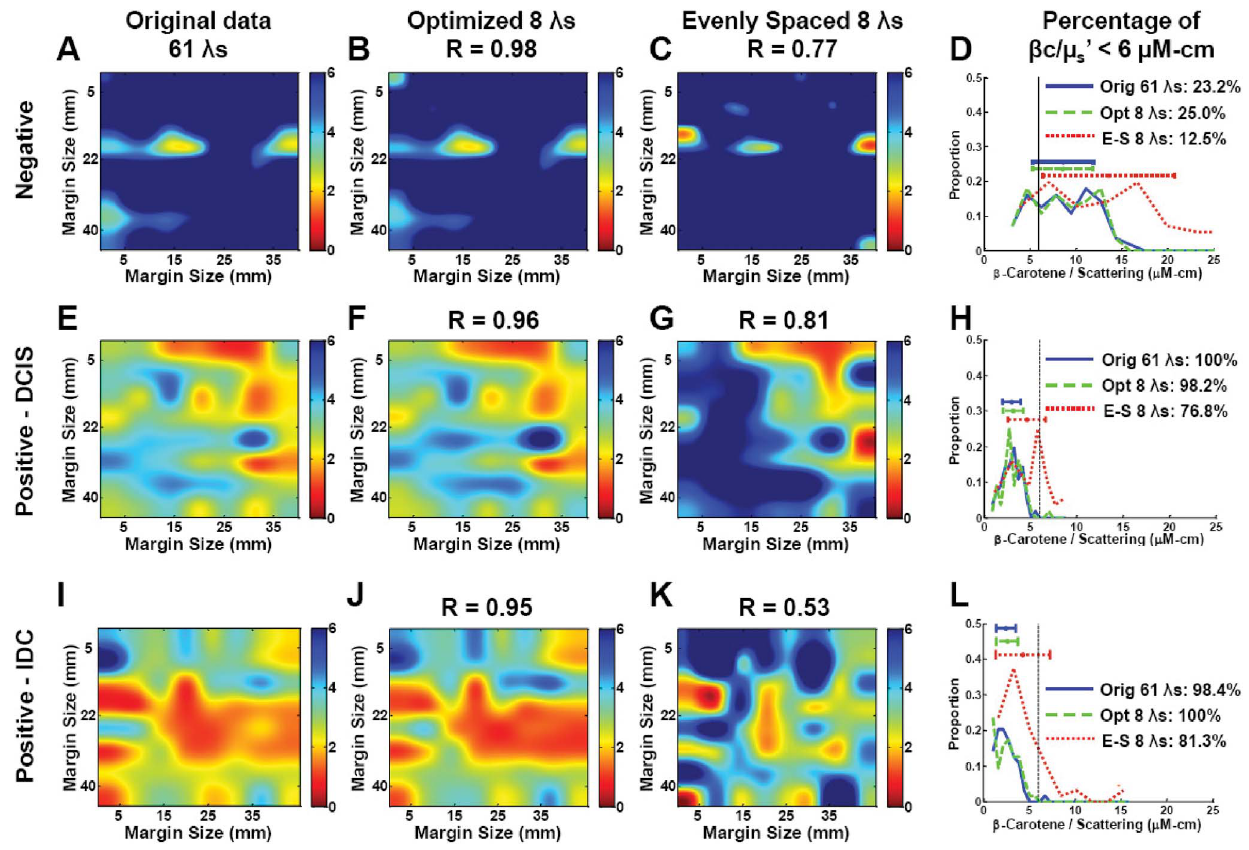
Figure 7. Example spectral images of negative and positive margins obtained with and without optimization. Representative margin maps of [ b c]/ , m s ’ . for normal (A–C), ductal carcinoma in situ (E–G), and invasive ductal carcinoma (I–K) using the full 450–600 nm spectrum, the optimized 8 wavelengths, and the un-optimized evenly spaced 8 wavelengths. Corresponding correlation coefficients for the 61-wavelength spectra and the reduced 8-wavelength spectra are shown. Distribution of the extracted b c/ m s ’ are shown in (D), (H), and (L) for each case, along with the threshold values used in the predictive model to separate positive from negative margins.